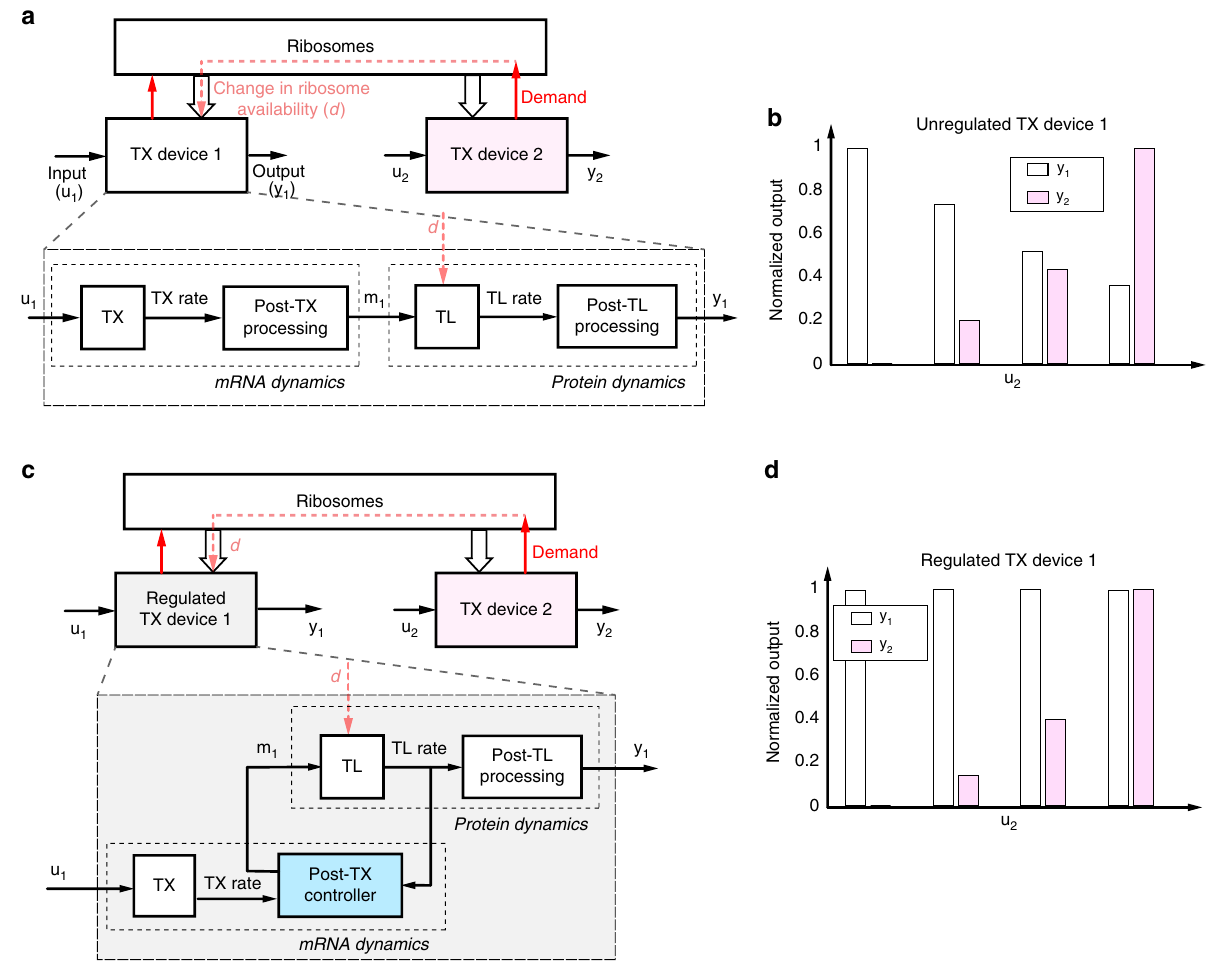
Fig. 1 The problem of modularity in resource-limited genetic circuits. a Each TX device i ( i = 1, 2) takes a TX regulator as input ( u i ) and produces a protein as output ( y i ). Each device can be decomposed into the cascade of key biological processes, here depicted as transcription (TX), post-TX